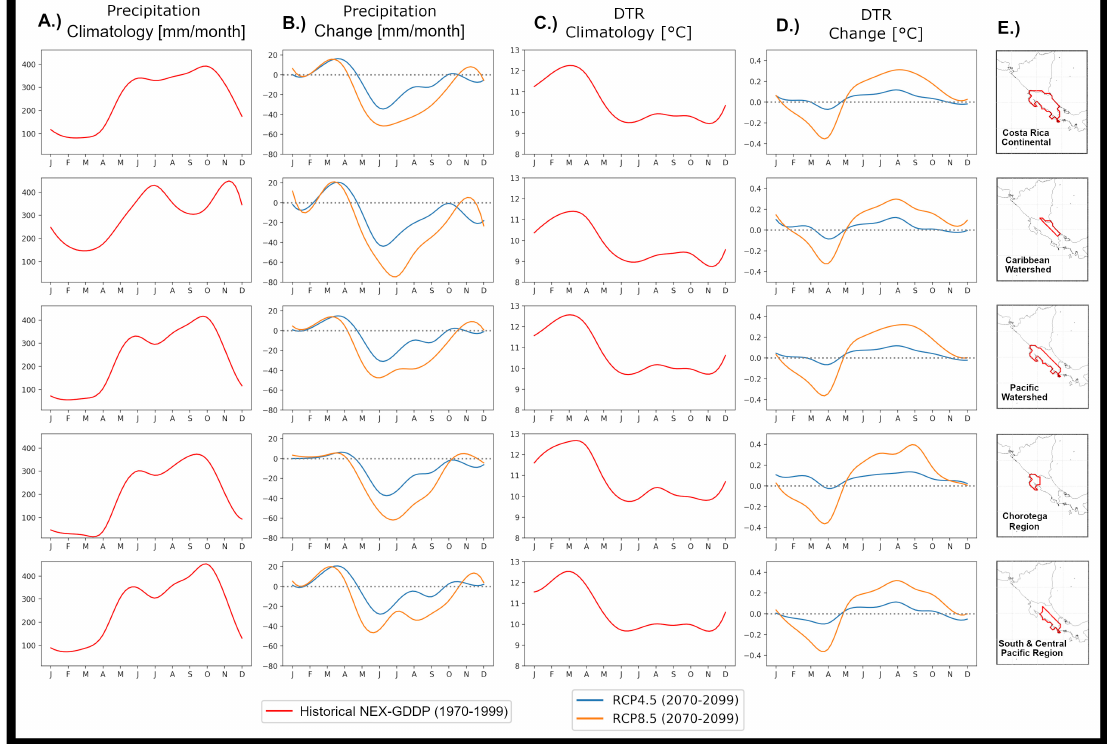
Figure 4. CMIP5 Monthly Multimodel Ensemble distributions for historical NEX-GDDP precipitation and diurnal temperature range (DTR) for the period 1970–1999 (column ( A ) and ( C ), respectively), and their corresponding future changes for the period 2070–2099 for RCP 4.5 and 8.5 scenarios (column ( B ) and ( D ), respectively), over Costa Rica different regions (column ( E